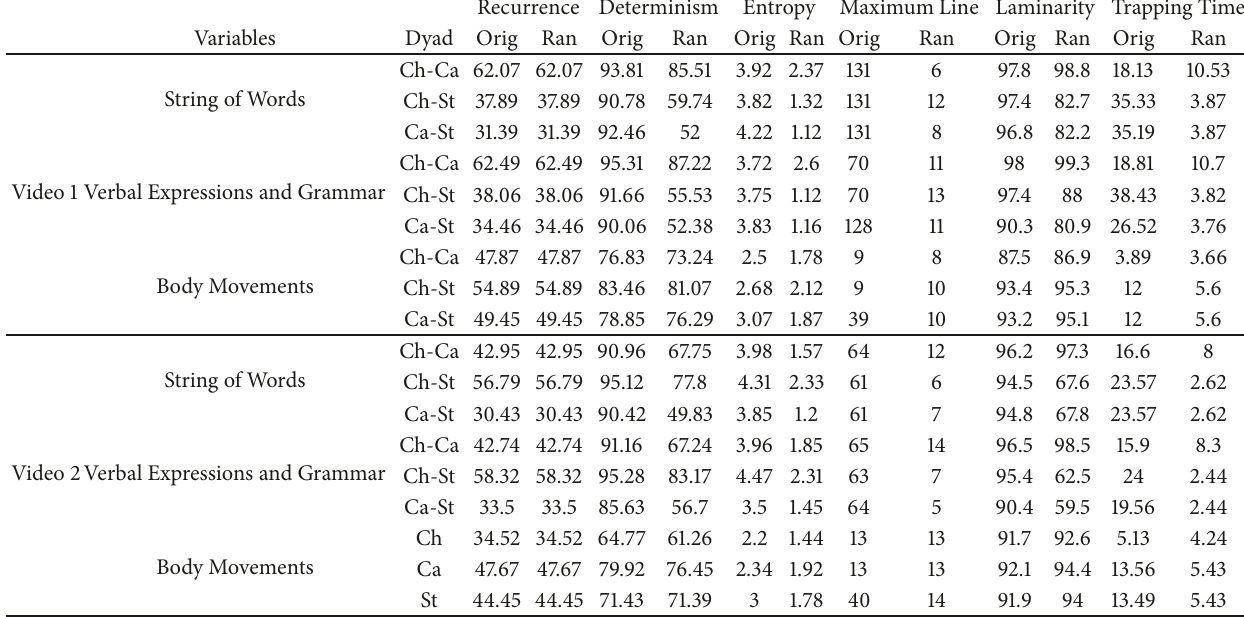
Table 5: Categorical CRQA measures for dyads in Videos 1 and